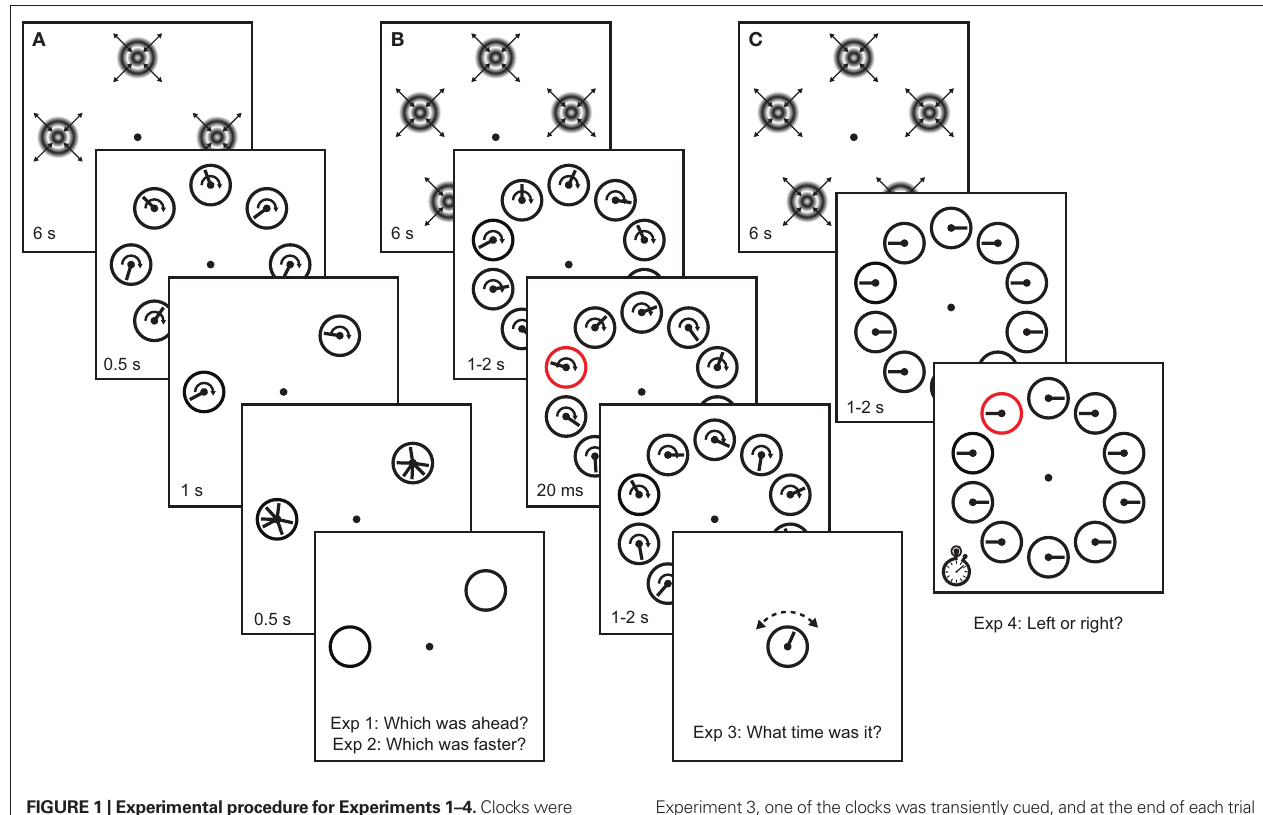
Figure 1 | experimental procedure for experiments 1–4. Clocks were presented in regions of the visual field that were either unadapted, or adapted to either 5 or 20-Hz drifting concentric gratings. (A) In Experiments 1 and 2, observers compared the hand position (Experiment 1) or speed (Experiment 2) of continuously running clocks in adapted and unadapted locations. (B) In